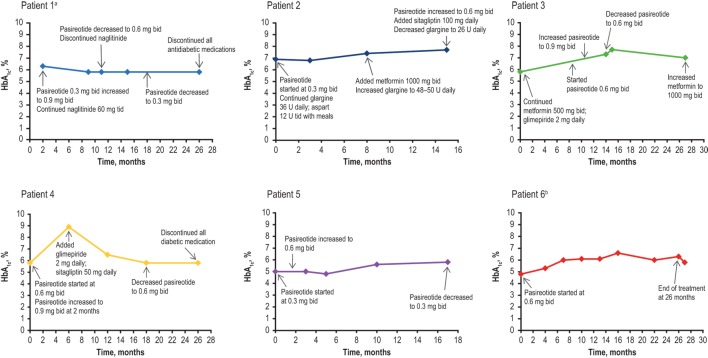
HbA1c levels of patients over the duration of treatment. bid, twice daily; HbA1c, glycated hemoglobin; tid, three times daily. aBaseline data not available. bMetformin 500 mg bid was prescribed before the initial HbA1c result and was stopped after 11 days when HbA1c results showed low values.